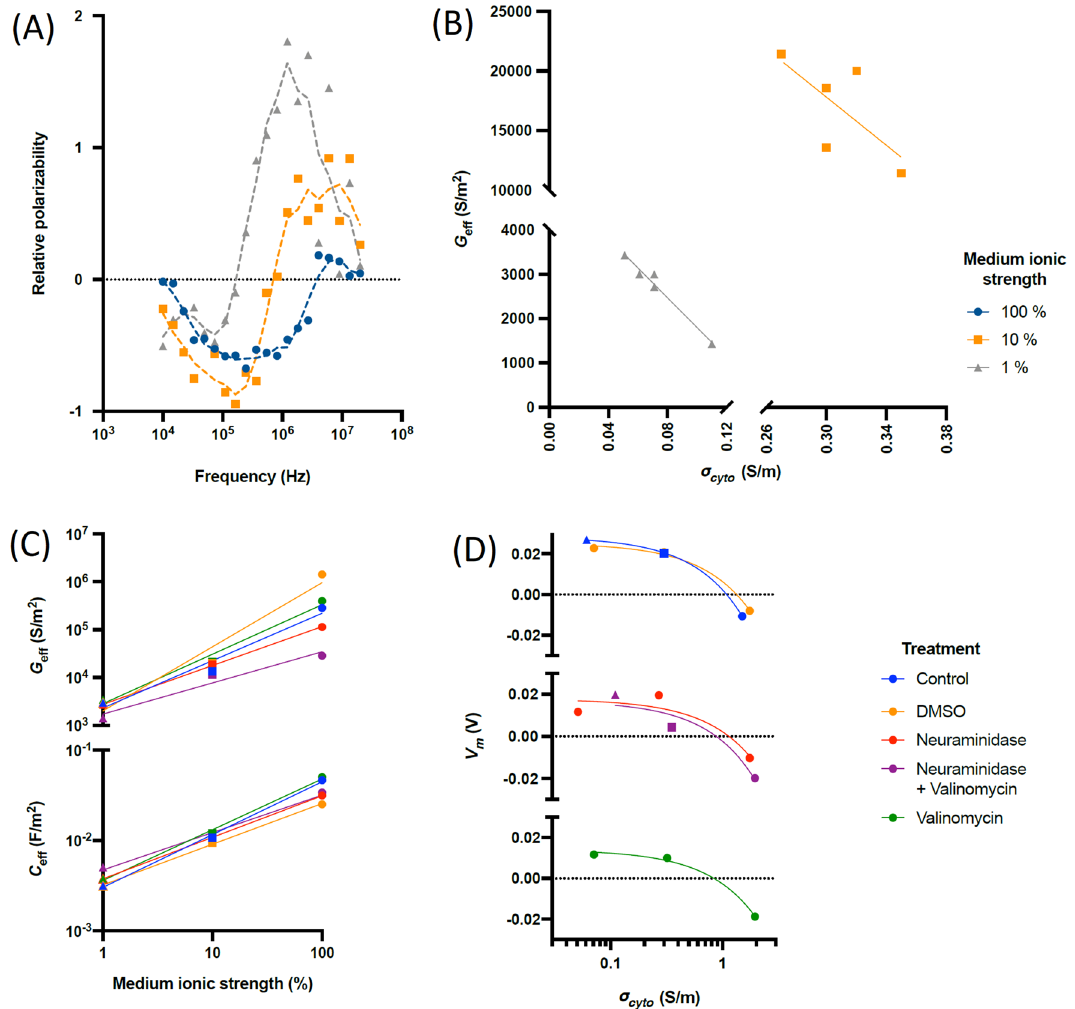
Figure 5. ( A ) The DEP spectra (points) of RBCs in media of different ionic strength (1% (grey), 10% (orange) and 100% (blue)) together with rolling average trendlines; ( B ) the values of G eff vs. σ cyto for 1% and 10% media, together with best-fit trendline; ( C ) Specific membrane conductance G eff and capacitance C eff as a function of medium ionic strength; ( D ) the relationship between cytoplasm conductivity σ cyto and membrane potential V m .